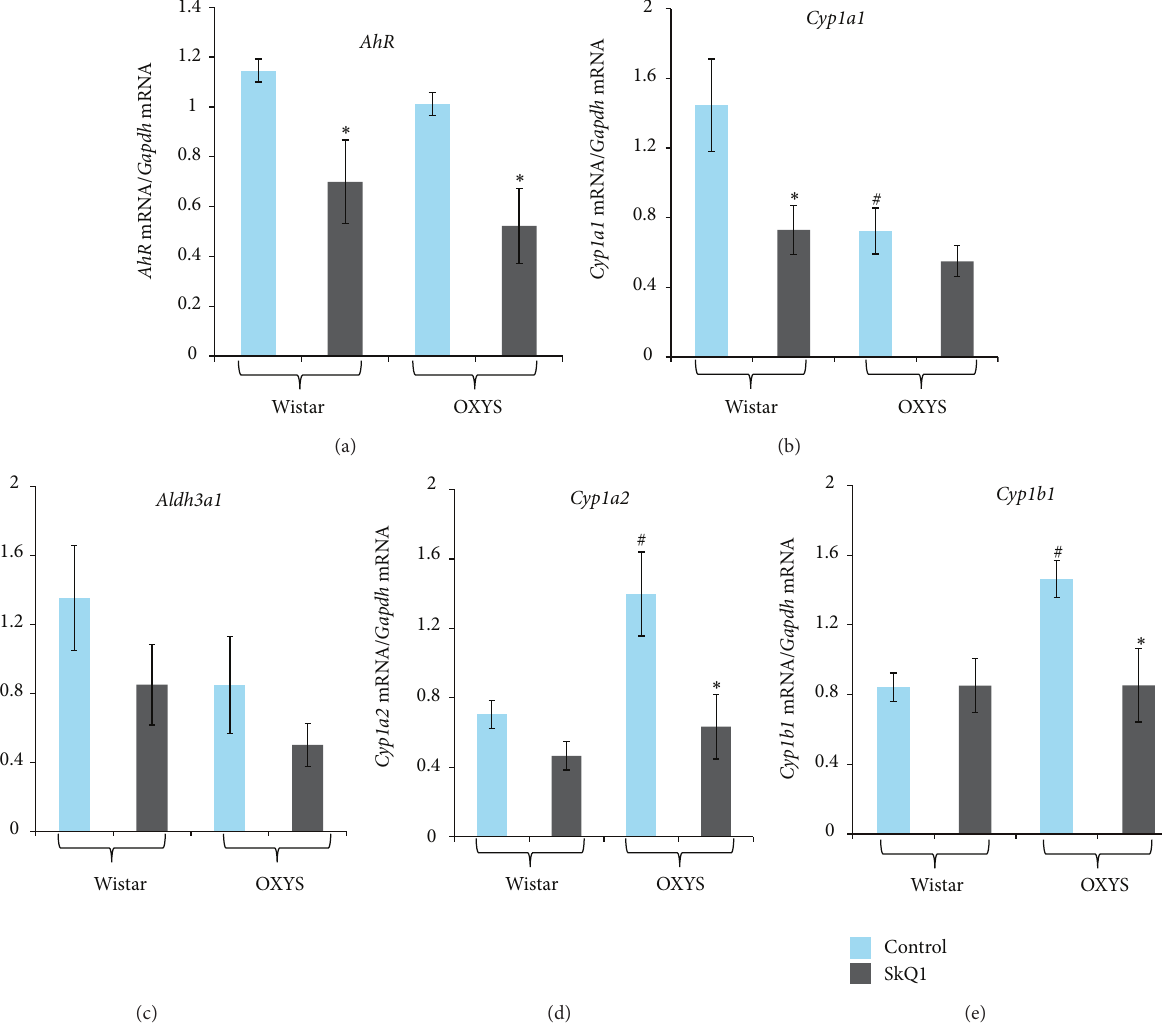
Figure 1: AhR (a), Cyp1a1 (b), Aldh3a1 (c), Cyp1a2 (d), and Cyp1b1 (e) mRNA levels in the retinas of 3-month-old Wistar and OXYS rats treated with SkQ1. All data are normalized to the expression level of a housekeeping gene ( Gapdh ). Values are presented as mean ± SEM ( 𝑛 = 6 to 8). Significant differences between groups are marked with ∗ 𝑃 < 0.05